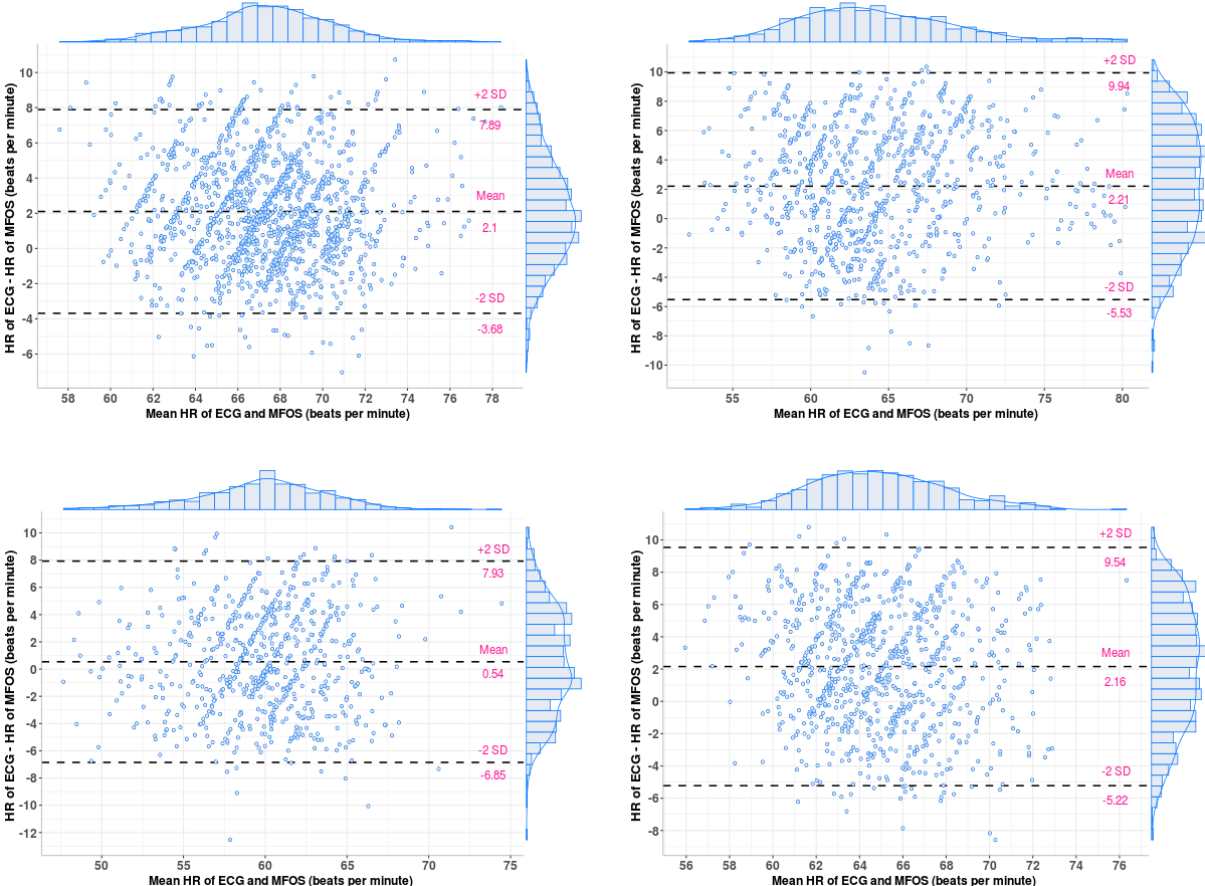
Figure 9. Bland-Altman plots of the heart rates for patients 1, 2, 6, and 10 (ie, top left, top right, bottom left, and bottom right, respectively). ECG: electrocardiogram; HR: heart rate; MFOS: microbend fiber optic sensor; RR: respiratory